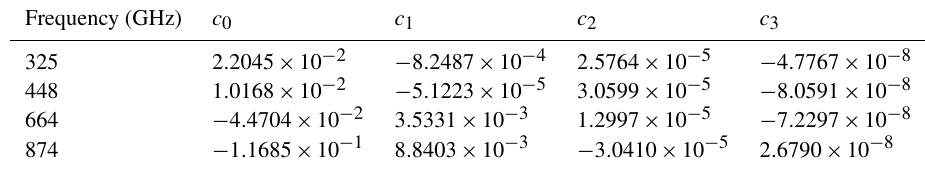
Table A3. Coefficients in the fitting of terahertz asymmetry factor.